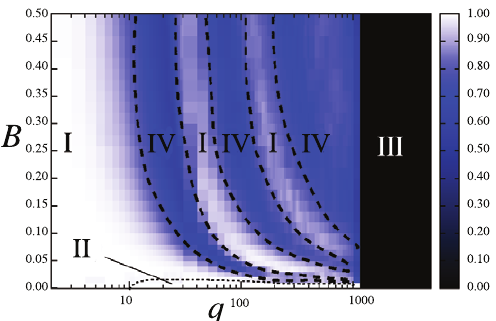
Figure 5. Phase diagram of population a on the space of parameters ( B , q ) , with F ~ 10 . System size is N ~ 800 with partition N a ~ 0 : 6 N . Each data point is averaged over 100 realizations of initial conditions. The color code represents the value of the normalized ~ 0 ) to white ( S 1 ~ 1 ). The regions , from black ( S 1 largest domain size S 1 a a a where the different phases occur are labeled and separated by slashed lines: phase I (both populations share same homogeneous state); phase IV (partially ordered, emergence of second group); phase III (disor- dered), and phase II (each population in a different homogeneous state). Localized ordered states can occur in the transitions from phase IV to phase I.